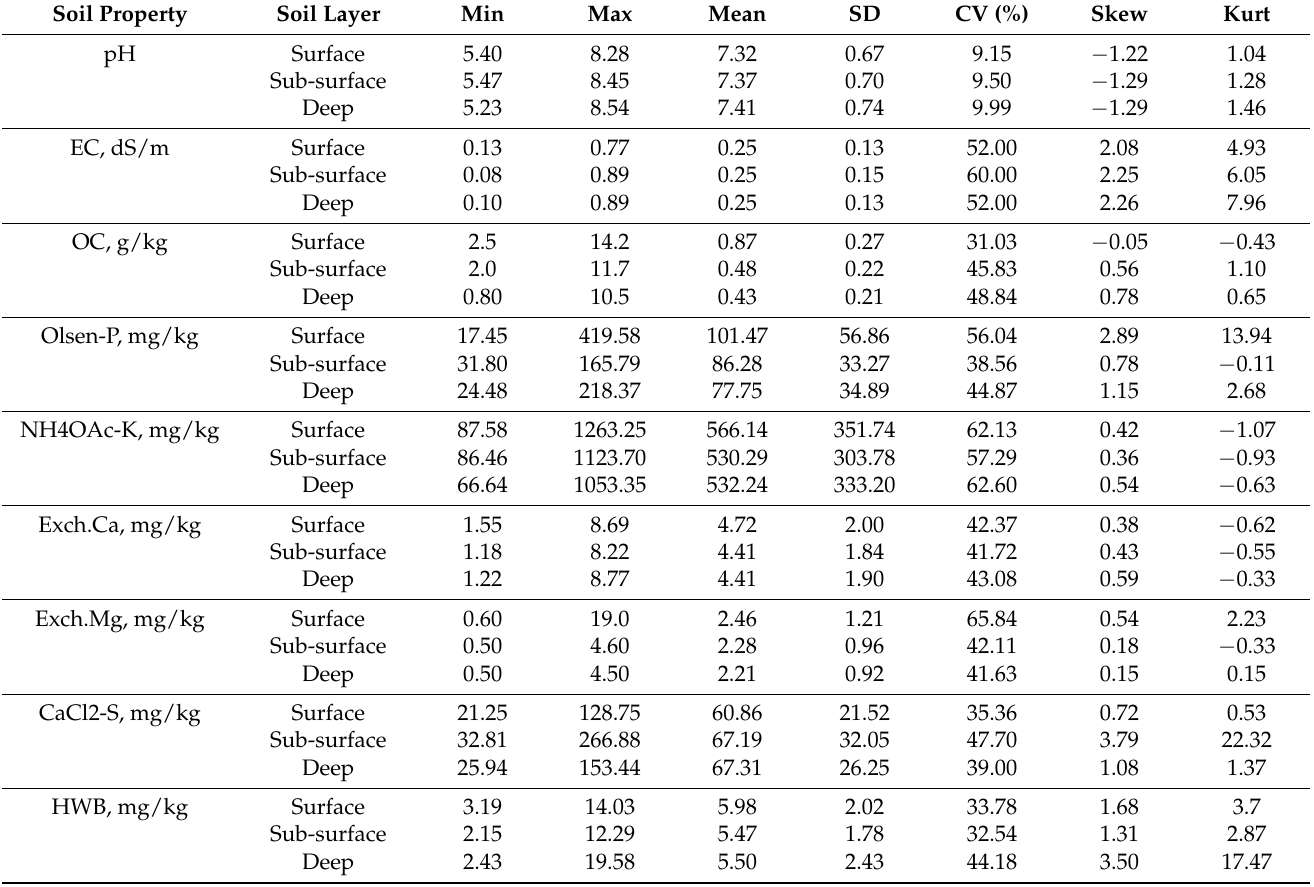
Table 2. Descriptive statistics * for selected soil properties of different soil layers (n =